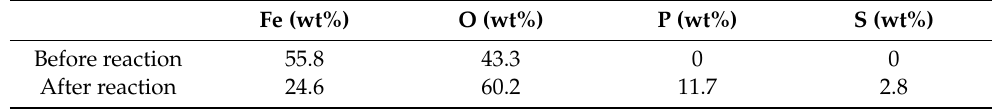
Table 1. EDS results of precipitates before and after reaction.